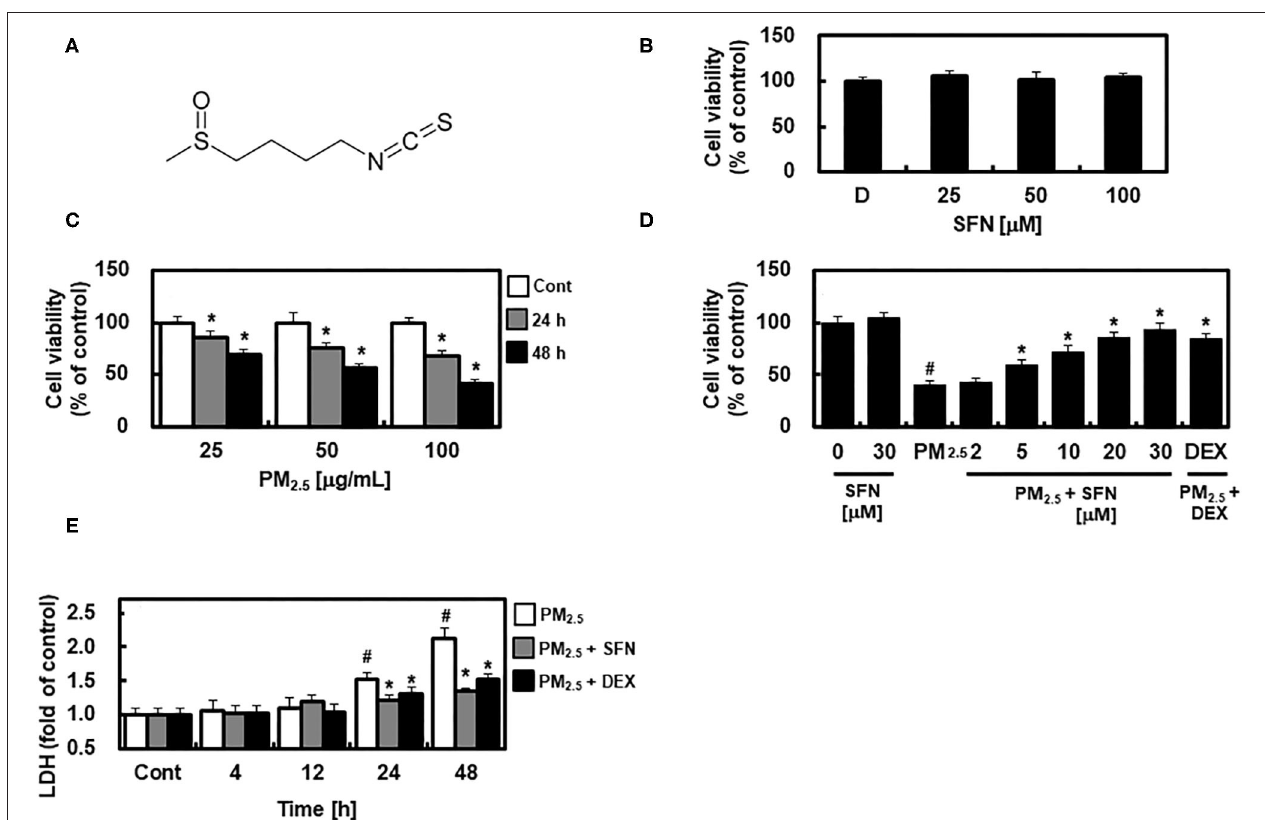
FIGURE 1 | Chemical structure of Sulforaphane (SFN) and effects of SFN on PM 2.5 -induced cell toxicity in ARPE-19 cells. (A) Chemical structure of SFN. (B) ARPE-19 cells were treated with 0.5% dimethyl sulfoxide as a control indicated as D, and 25, 50, or 100 µ M SFN for 24h, and cell viability was measured using an MTT Assay. (C) ARPE-19 cells were treated with 25, 50, or 100 µ g/mL PM 2.5 for 24 or 48h, and cell viability was measured using an MTT assay. (D) ARPE-19 cells were treated with the specified concentrations of SFN or DEX (1 µ M) for 6h after 24h PM 2.5 challenge (100 µ g/mL). After treatment, cell viability was determined using an MTT assay. (E) ARPE-19 cells were treated with SFN (50 µ M) or DEX (1 µ M) for 6h after PM 2.5 challenge (100 µ g/mL) for the indicated time periods. Subsequently, LDH levels were determined using an LDH kit. Values represent the mean ± SD of three independent experiments. * p < 0.01 relative to control (C) or